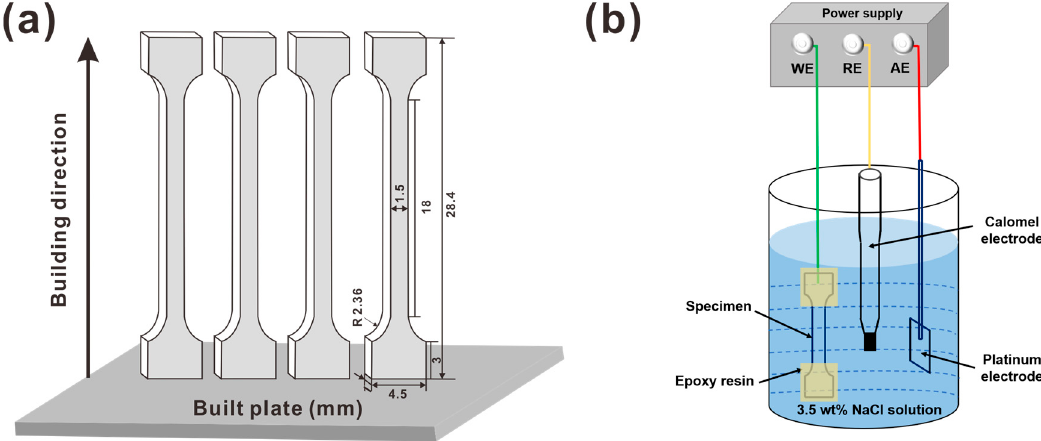
Figure 1. Diagram of ( a ) tensile sample, ( b ) the cathodic hydrogen charging process.